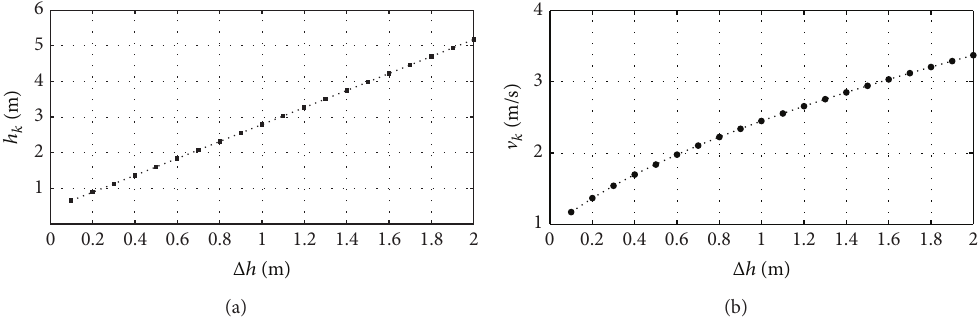
Figure 7: (a) Characteristics of water level and (b) flow velocity (dashed circle) at Katulampa with respect to uniform increasing of initial water level of all